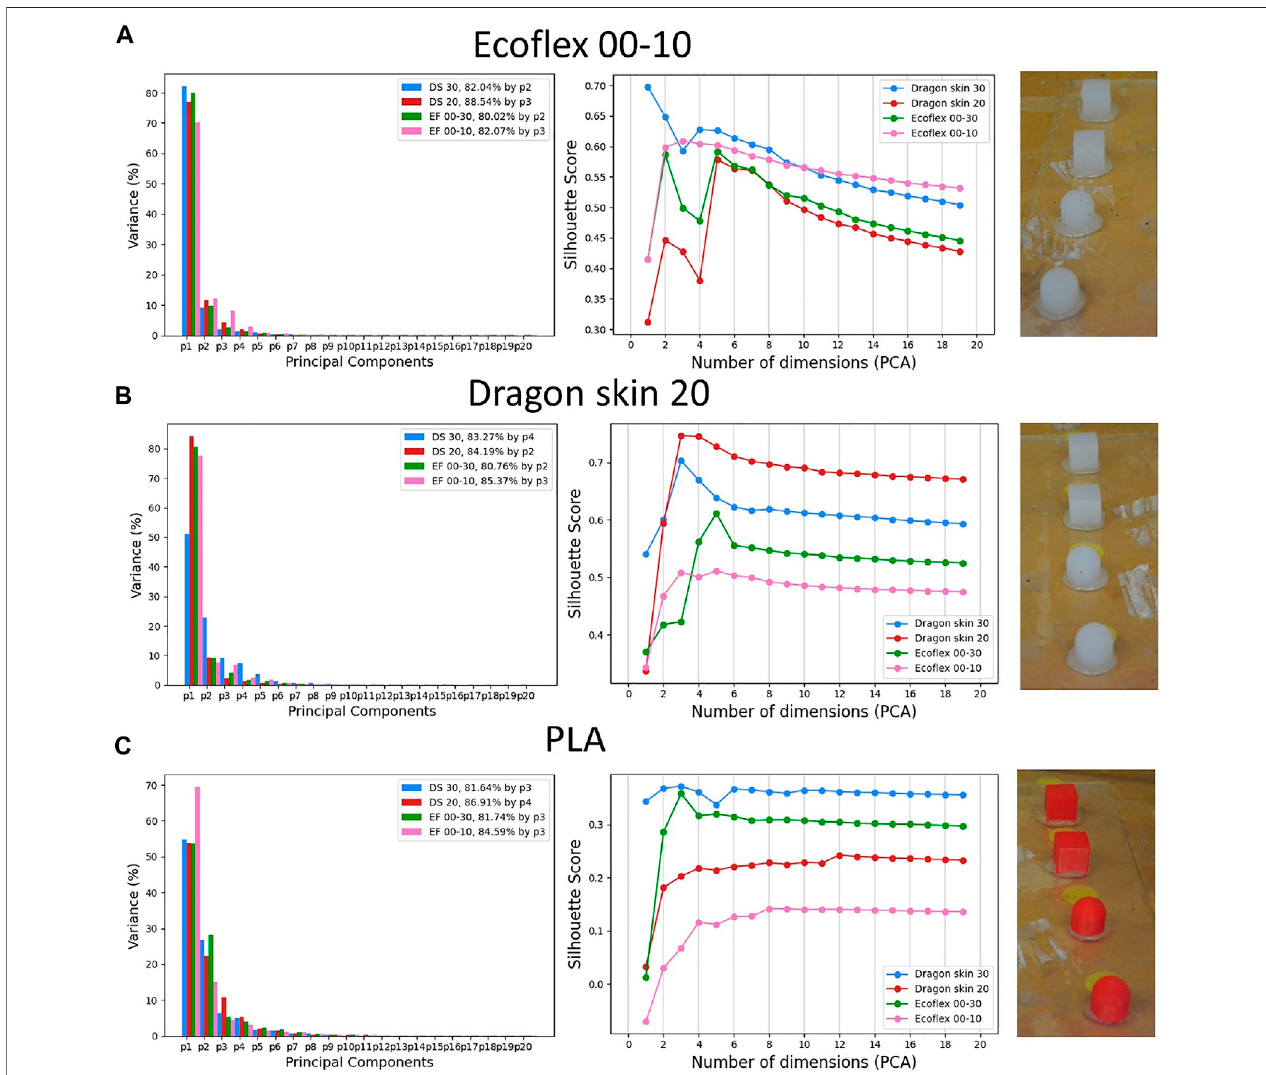
FIGURE 9 | PCA variance retention and silhouette score when testing the fi lter ’ s material on the three different subsets made by test objects of the same material: Eco fl ex 00 – 10 (A) , Dragon Skin 20 (B) , and PLA (C) .